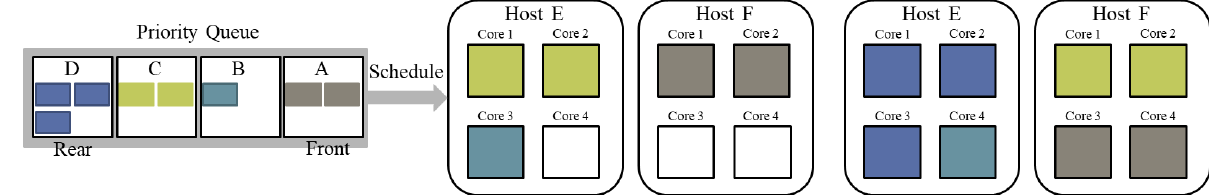
Figure 2. A case of